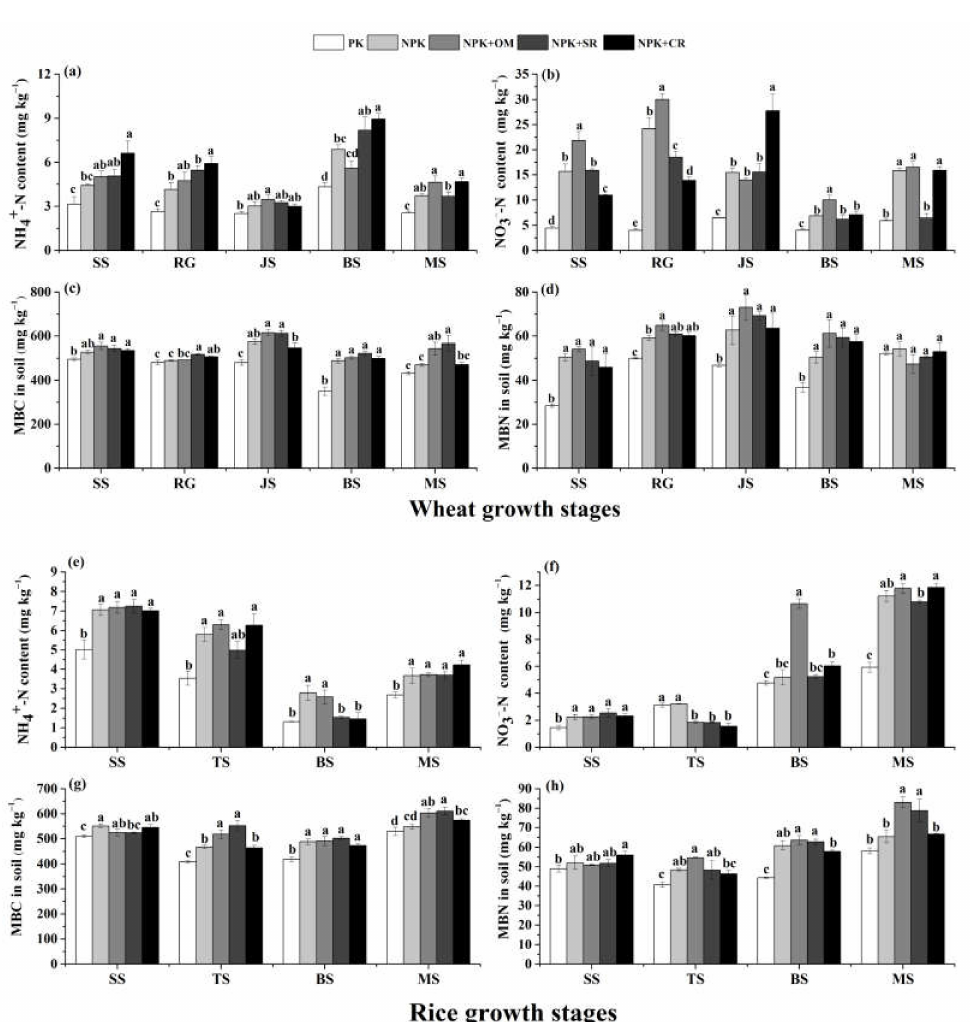
Figure 2. Effect of different fertilizer treatments on ( a , e ) NH 4+ -N, ( b , f ) NO 3 − -N, ( c , g )microbial biomass carbon (MBC), ( d , h ) microbial biomass nitrogen (MBN) content in the 0–20 cm topsoil layer during the wheat season and the rice season, respectively. Data are Mean ± S.E. (n = 3) and value followed by different letters between treatments represent significant differences at p < 0.05. (SS: Seeding stage, RG: Return green stage, JS: Jointing stage, BS: Booting stage, MS: Mature stage, TS: Tillering